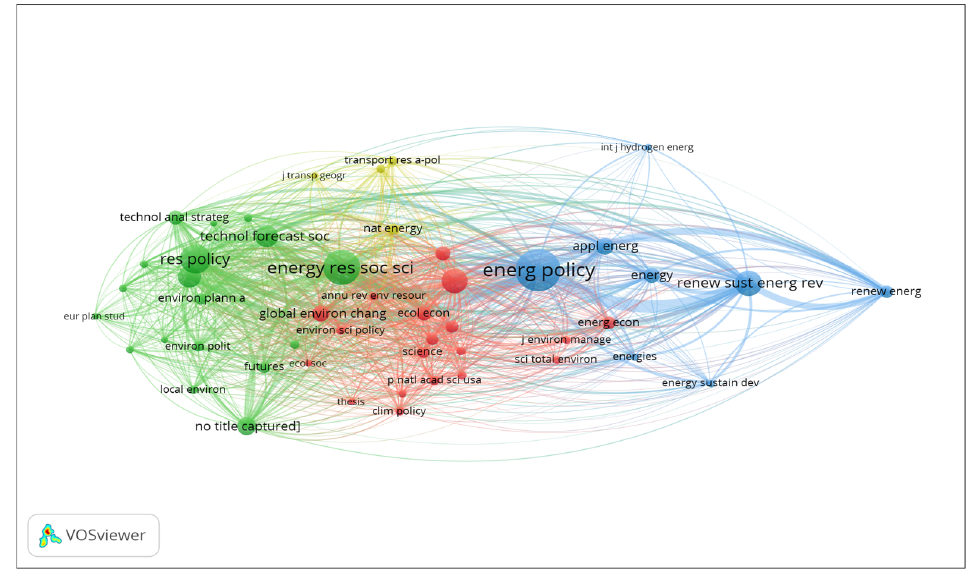
Figure 6. VOSviewer diagram containing the most cited journals, for the couple: social innovation– energy transition.